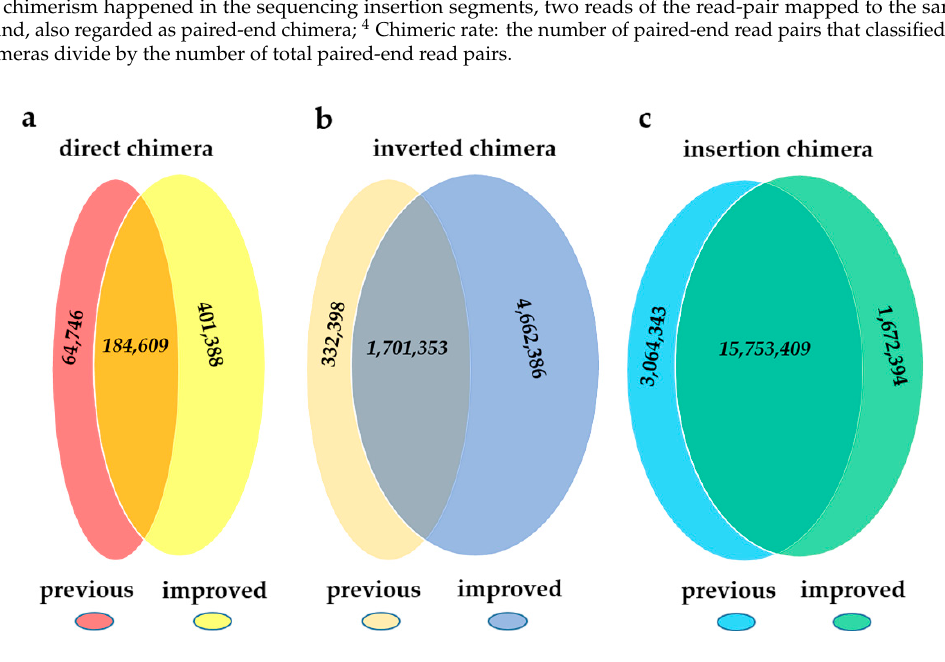
Figure 2. The comparison of two pipelines on MDA1. ( a ) direct chimera; ( b ) inverted chimera; ( c ) insertion chimera.